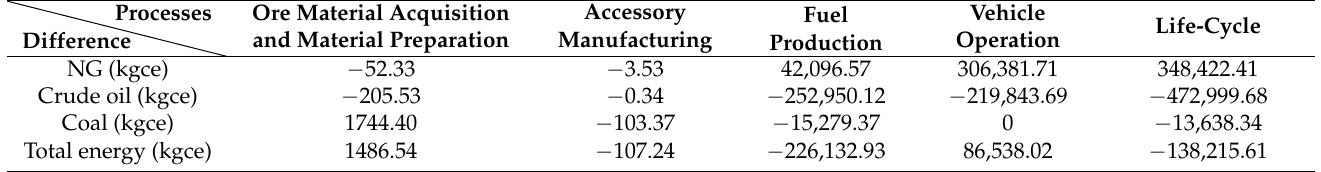
Table 5. Energy consumption of the LNG tractor-trailer compared to the diesel